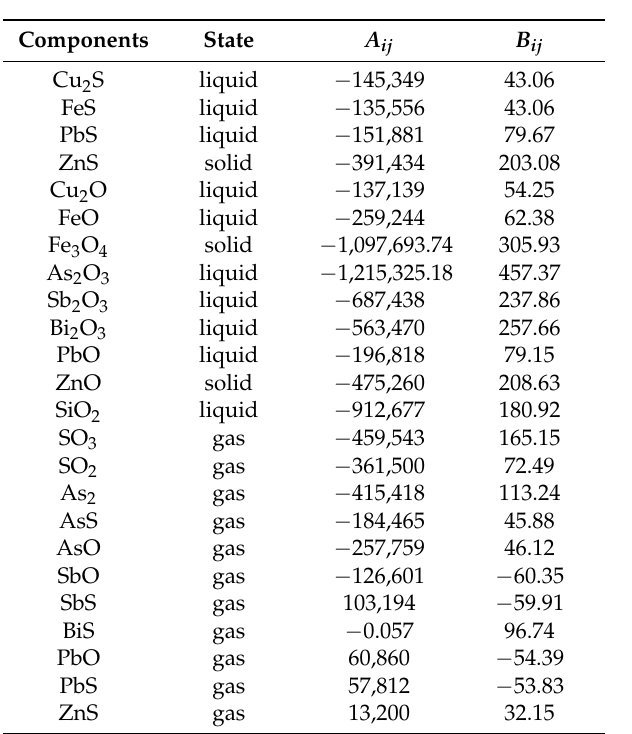
Table 3. Standard Gibbs free energy (J · mol − 1 ) of the formation of each